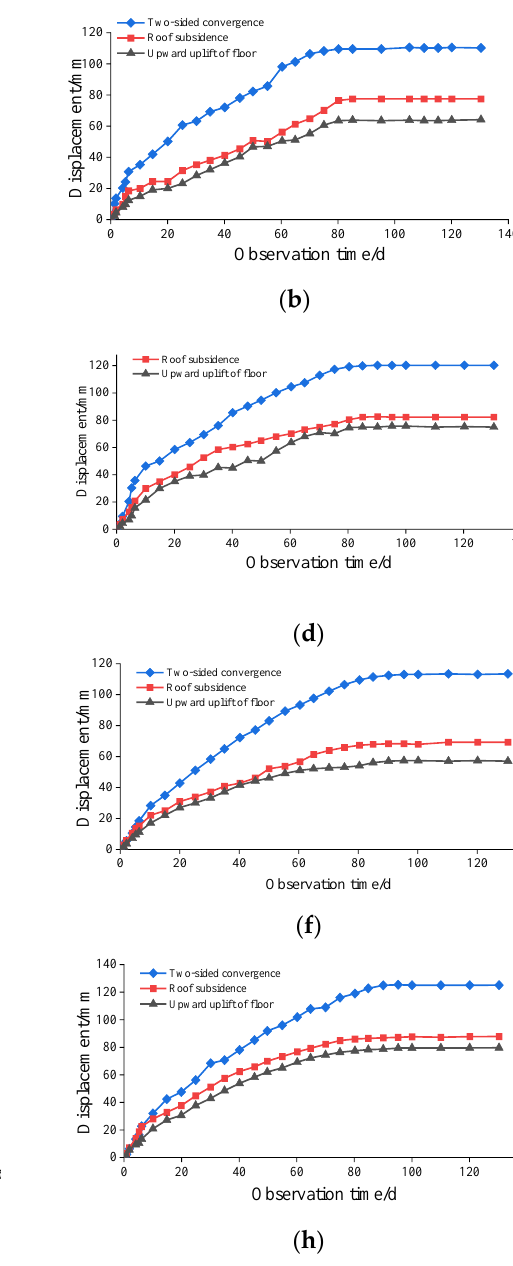
Figure 18. Numerical simulation results versus the field monitoring results of the maximum two- sided displacement.